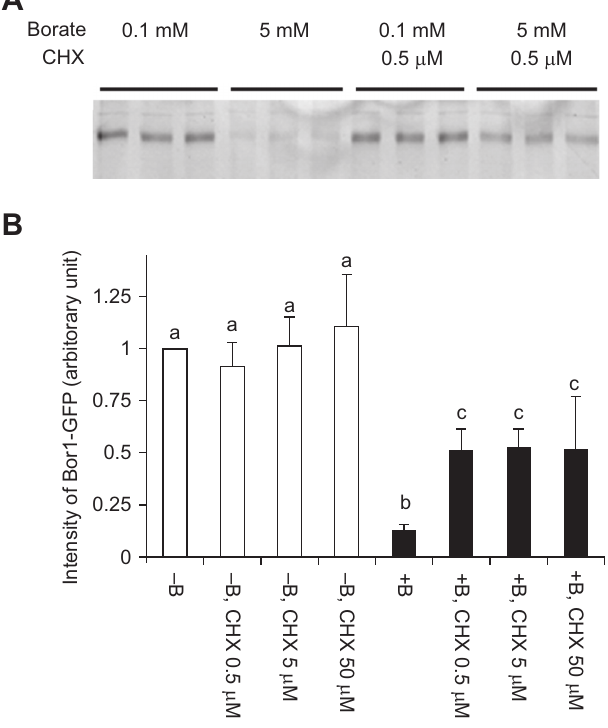
Figure 5. Cycloheximide partially inhibited the borate-dependent degradation of BOR1-GFP. Cells were incubated with normal (0.1 mM) or high (5 mM) concentrations of borate with or without cycloheximide for 2 hours. A . Image of BOR1-GFP fluorescence after separation by SDS-PAGE. CHX: cycloheximide. B . Quantified result of A. Means of three independent triplicated experiments plus standard deviations are shown a, b and c above the error bars indicate that values in each letter showed significant difference whereas marked with the same letter showed no significant difference (p<0.01) using Tukey’s